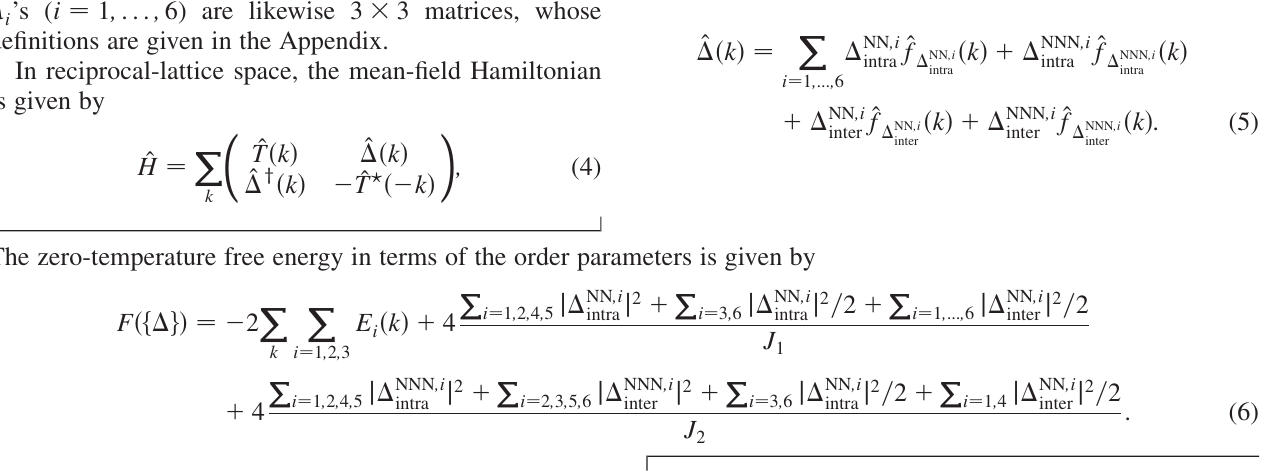
FIG. 2. (a) Mean-field phase diagram along J space. Size of the gap around Fermi surfaces at (b) J ¼ 1 : 5 . In the left half of (b) and (c), the k point traces the (c) J 2 electron pocket around the X point counterclockwise from point A in Fig. 1, while in the right half it traces the electron pocket around the Y point counterclockwise from point B in Fig.